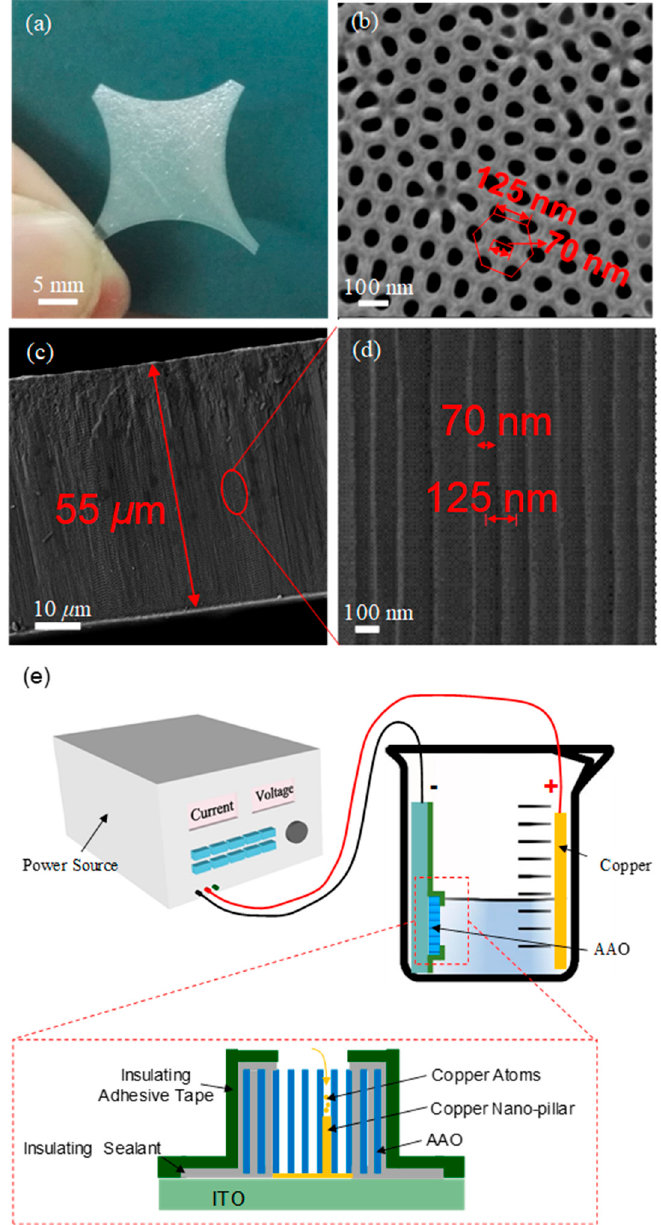
Figure 2. ( a ) Optical image, ( b ) top view, ( c ) cross-sectional, ( d ) magnified images of AAO and ( e ) the installation for electrodeposition.